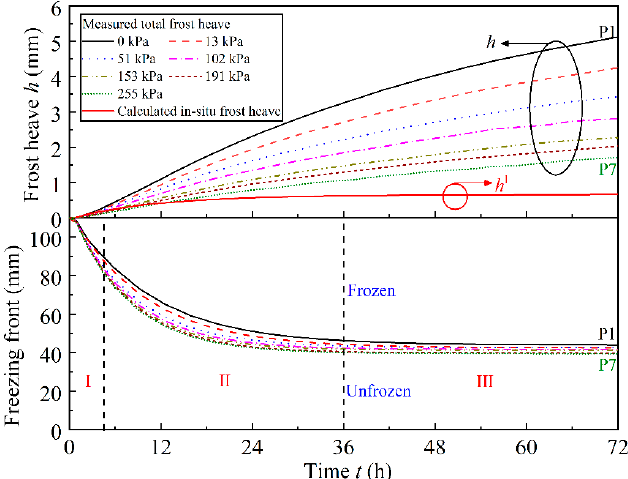
Figure 5. Variations of real frost heave and freezing front with freezing time under external pressures.